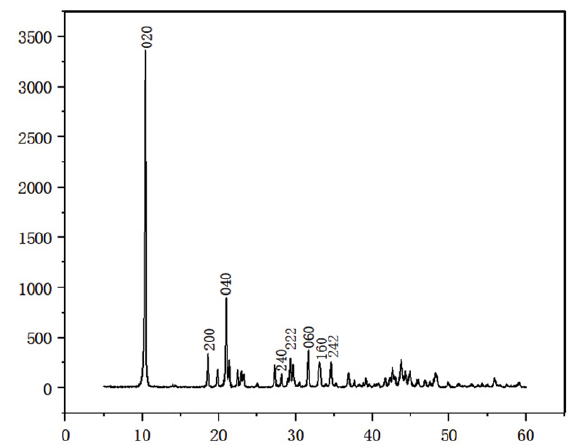
Figure 12. Transmission electron microscope image of hexagonal flake cerium carbonate crystal Figure 14. XRD pattern of hexagonal flake cerium carbonate